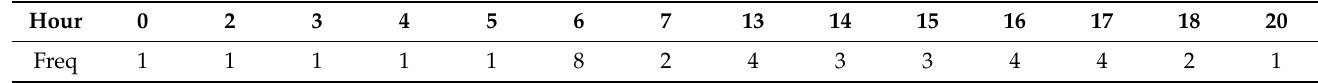
Table 11. Timeslots with high HVAC consumption when the number of users is low.